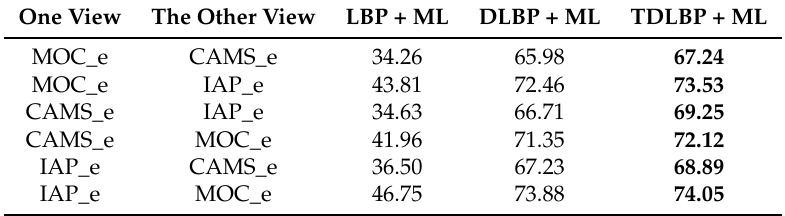
Table 4. Multi-view cloud recognition accuracies (%) using LBP, DLBP, and TDLBP with metric